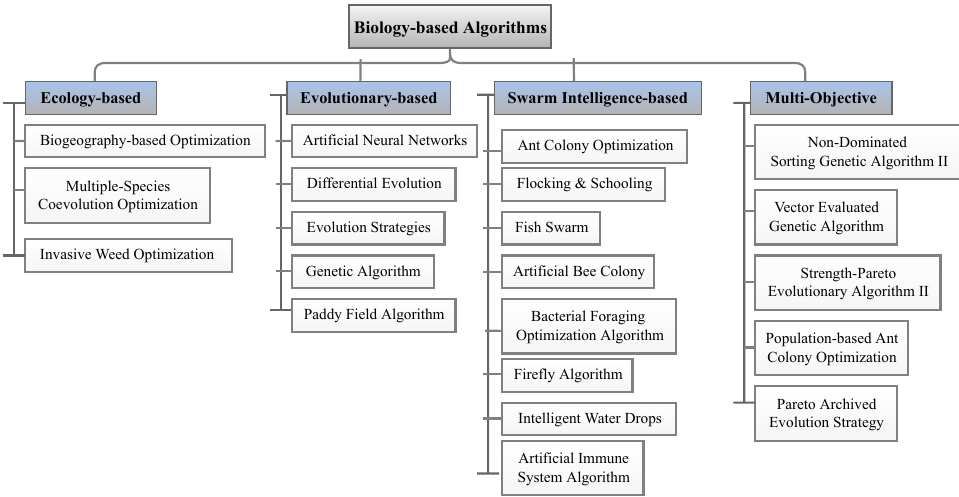
Figure 11. Classification of biology-based